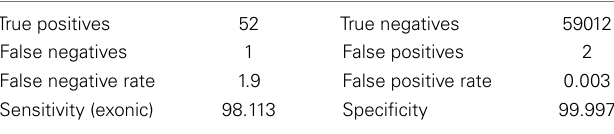
Table 2 | Summary of comparison of NGS and Sanger sequencing results (n = 33 samples) .